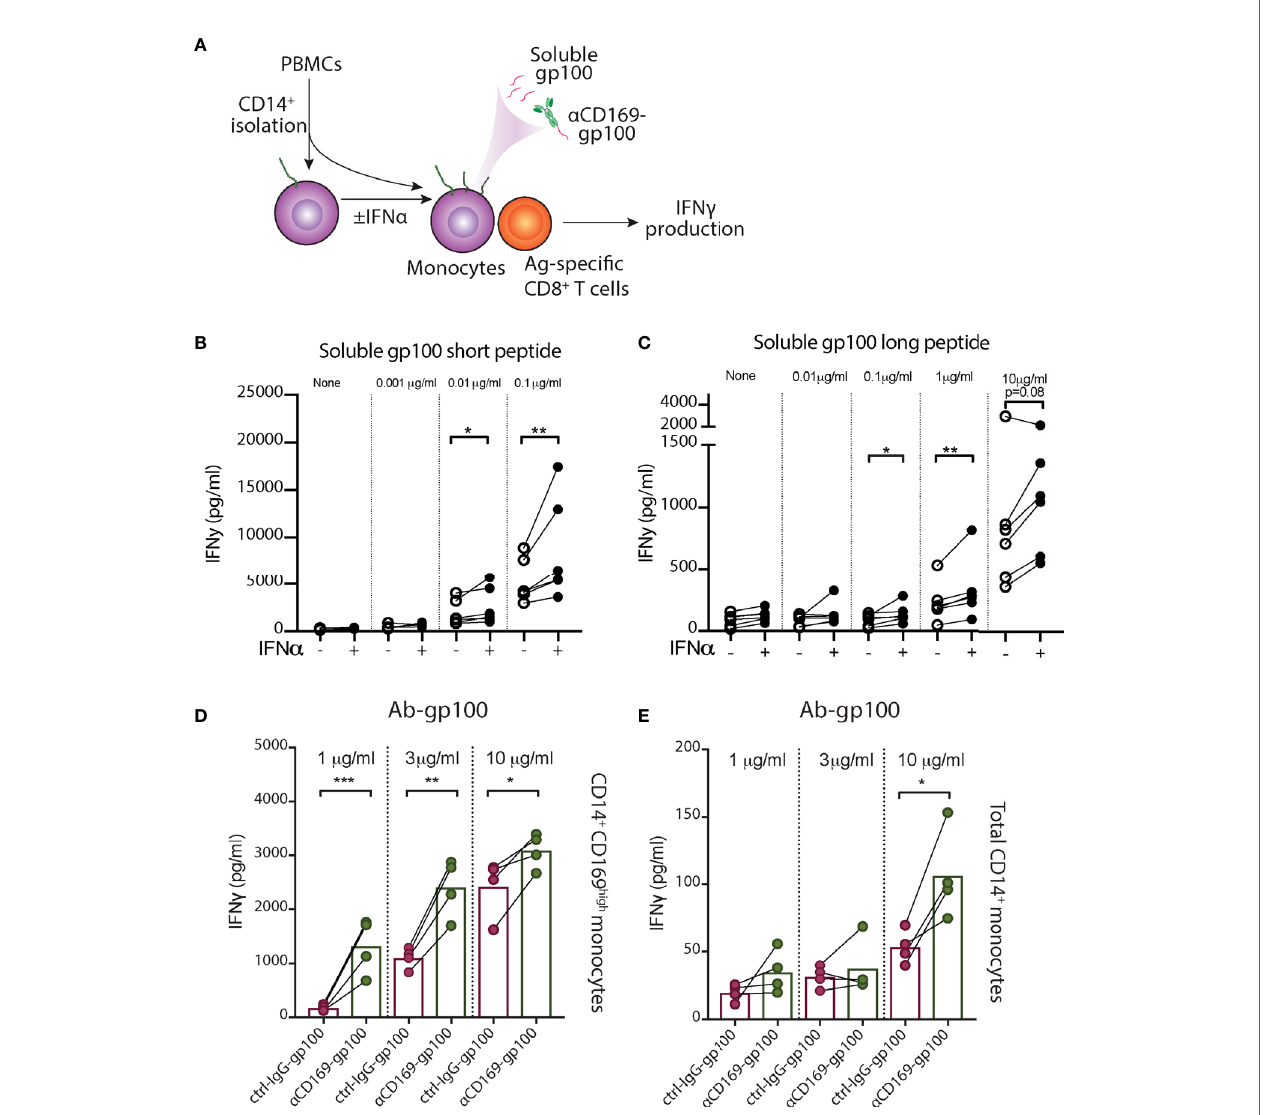
FIGURE 4 | IFN- a treated monocytes showed enhanced peptide presentation to CD8 + T cells. (A – C) After CD14 + isolation, monocytes were incubated with IFN a overnight, loaded with different concentrations of gp100, washed, and gp100-speci fi c CD8 + T cells were added. After 24h, IFN g secretion by CD8 + T cells after co- culture with monocyte loaded with (B) short peptide or (C) long peptide was measured by ELISA. (D, E) Targeted antigen delivery to CD14 + CD169 + monocytes using antibody conjugated with gp100 peptide. (D) IFN a -treated CD14 + CD169 high monocytes or (E) freshly-isolated total CD14 + monocytes were loaded with different doses of a CD169-gp100 or control IgG-gp100 antibody-conjugates, washed, and gp100-speci fi c CD8 + T cells were added. After 24h IFN g secretion was measured by ELISA. Data are mean from four donors. Paired t-tests were used. *P < 0.05, **P < 0.01, ***P <